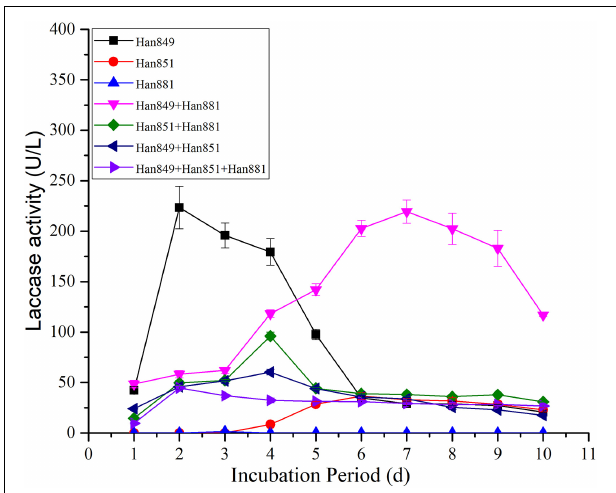
FIGURE 4 | Laccase activity from single or mixed fungal species on Pinus tabuliformis and Firmiana platanifolia in submerged fermentation.